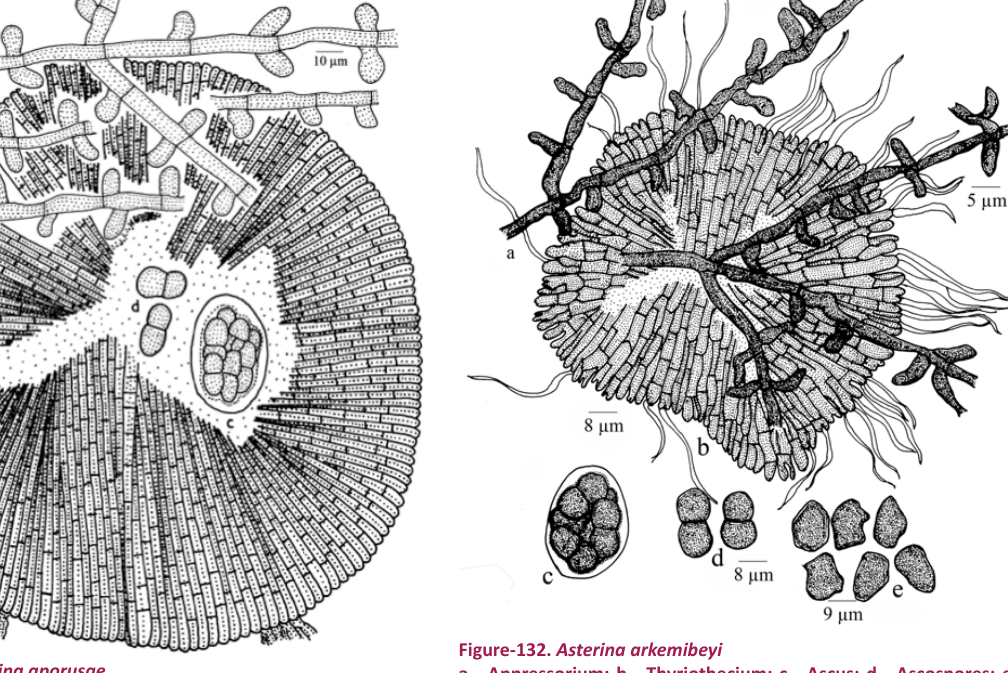
Figure 131. Asterina aporusae a - Appressorium; b - Thyriothecium; c - Ascus; d - Ascospores